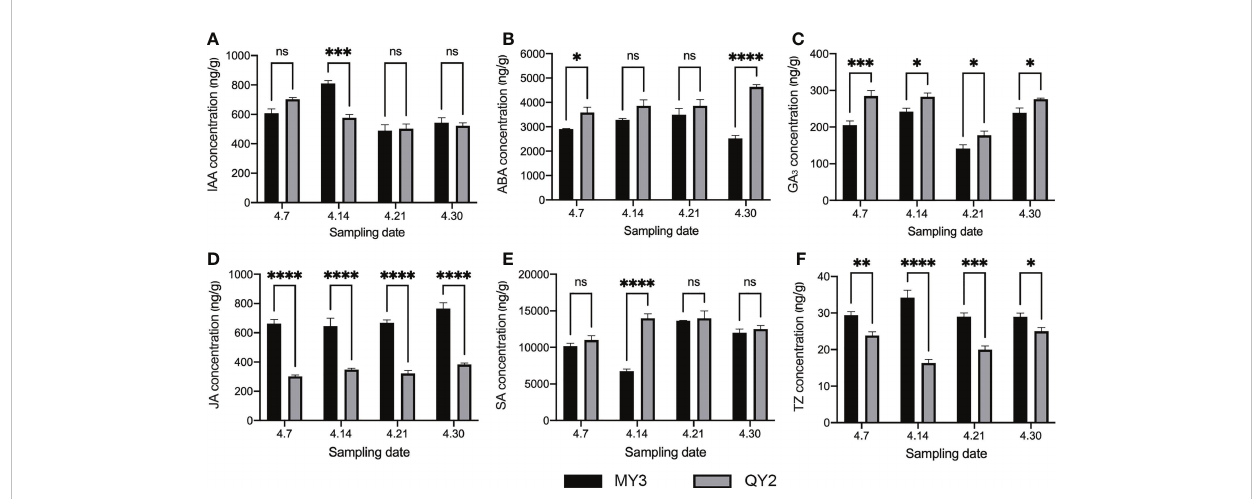
FIGURE 4 Endogenous hormones in buds during formation between two cultivars of Camellia oleifera . A : IAA; B : ABA; C : GA 3 ; D : JA; E : SA; F :TZ. Black represents MY3, gray represents QY2. *: p<0.05, **: p<0.01, ***: p<0.001, ****: p<0.0001, ns: Not signi fi cant. All values represent the means of biological triplicates.